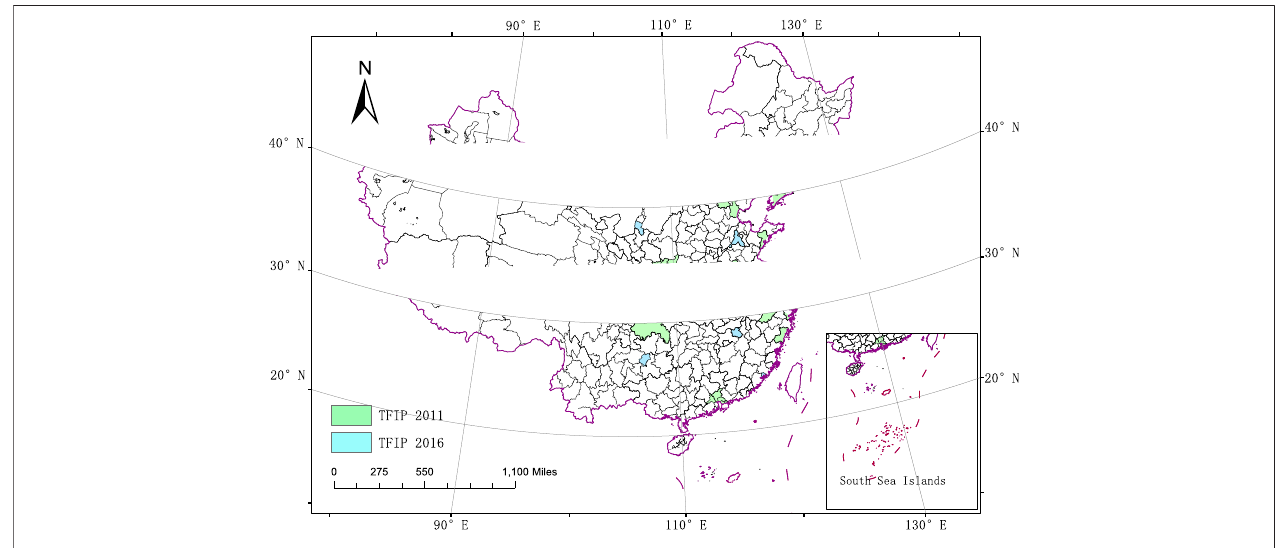
FIGURE 1 | TFIP pilot cities. The fi rst batch of pilot cities include 41 cities (Beijing, Tianjin, Shanghai, Chongqing, Nanjing, Wuxi, Lianyungang, Huaian, Yancheng, Xuzhou, Changzhou, Nantong, Suzhou, Zhenjiang, Yangzhou, Suqian, Taizhou, Hangzhou, Wenzhou, Ningbo, Huzhou, Hefei, Wuhu, Bengbu, Guangzhou, Foshan, Dongguan, Shenzhen, Xi ’ an, Weinan, Shangluo, Tongchuan, Baoji, Xianyang, Chengdu, Mianyang, Wuhan, Changsha, Dalian, Qingdao, and Tianshui). The second batch of TFIP pilot cities include nine cities (Zhengzhou, Xiamen, Ningbo, Jinan, Nanchang, Guiyang, Yinchuan, Baotou, and Shenyang).